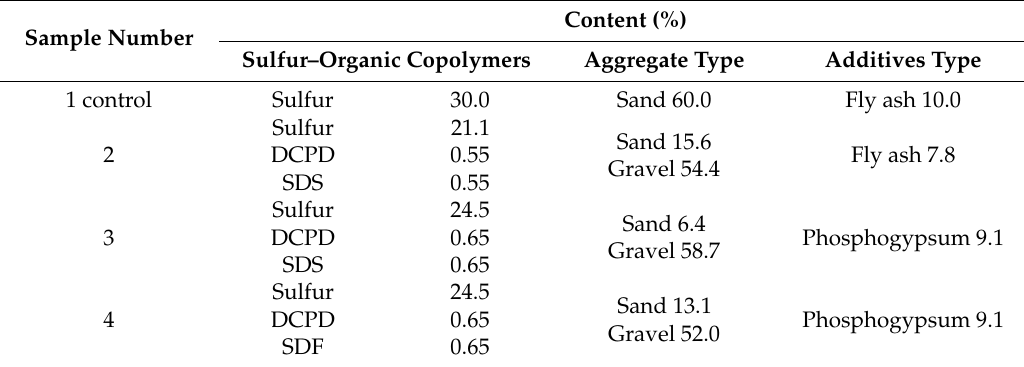
Table 2. Composition of the sulfur–concrete